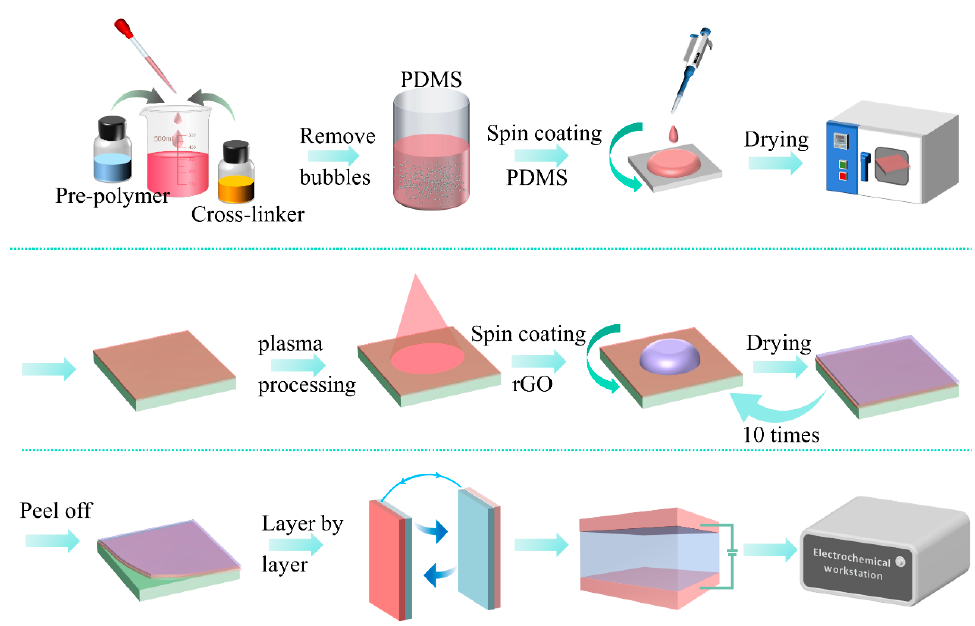
Figure 2. Schematic diagram of the fabrication process of the reduced graphene oxide- polydimethylsiloxane (rGO-PDMS) sensor.